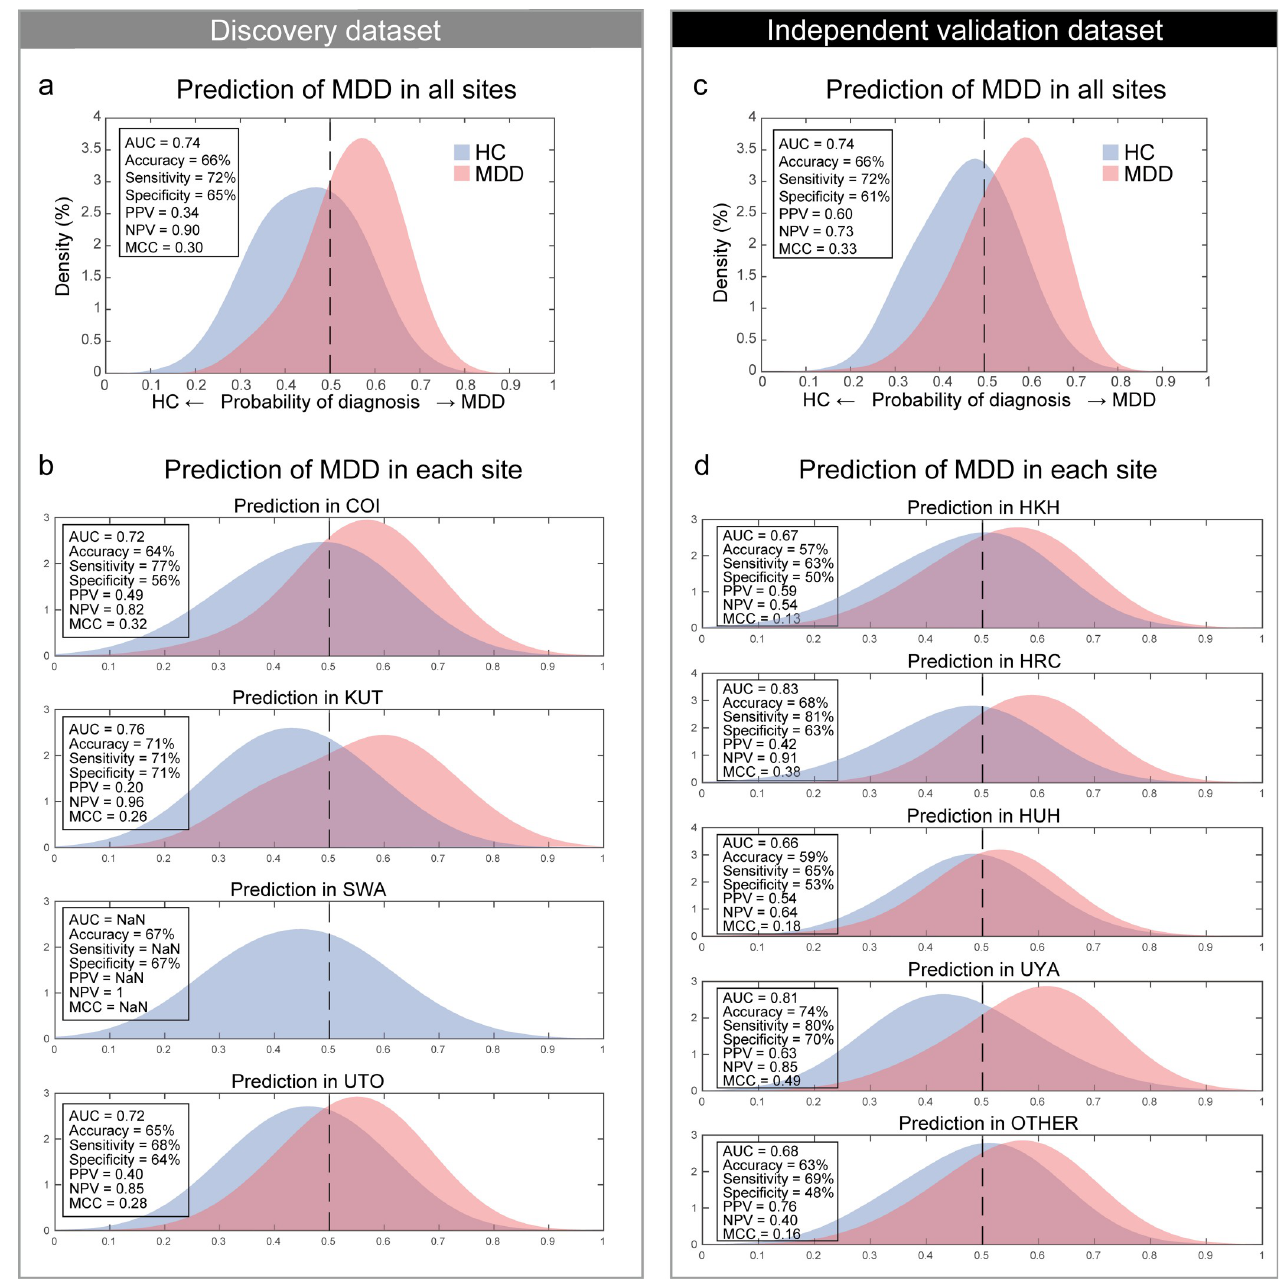
Fig 3. MDD classifier performances in both datasets. (a) The probability distribution for the diagnosis of MDD in the discovery dataset and (b) probability distributions for each imaging site. MDD and HC distributions are depicted in red and blue, respectively. (c) The probability distribution for the diagnosis of MDD in the independent validation dataset and (d) probability distributions for each imaging site. MDD and HC distributions are depicted in red and blue, respectively. The numerical data used in this figure are included in S1 Data. AUC, area under the curve; COI, Center of Innovation in Hiroshima University; HC, healthy control; HKH, Hiroshima Kajikawa Hospital; HRC, Hiroshima Rehabilitation Center; HUH, Hiroshima University Hospital; KUT, Kyoto University; MCC, Matthews correlation coefficient; MDD, major depressive disorder; NPV, negative predictive value; PPV, positive predictive value; SWA, Showa University; UTO, University of Tokyo; UYA, Yamaguchi University. OTHER, the data from OpenNeuro (https://openneuro.org/datasets/ds002748/ versions/1.0.0).